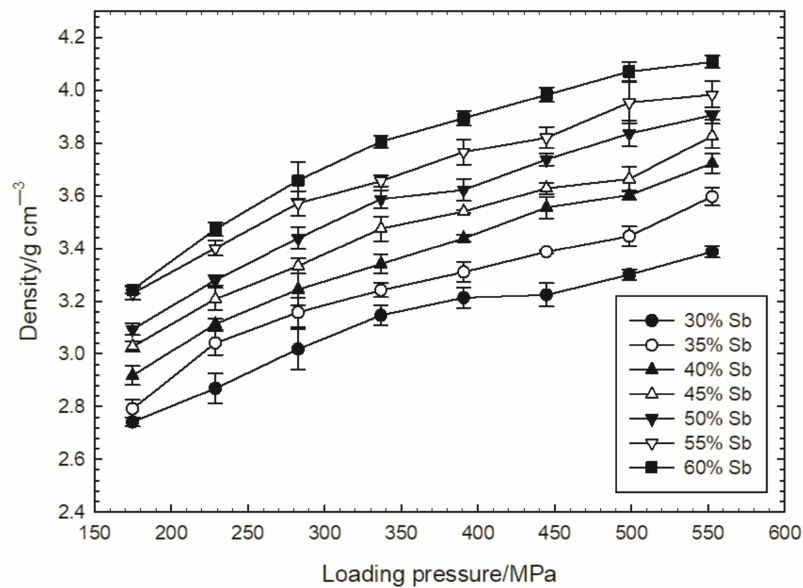
Figure 4. Dependence of the delay composition density on the loading pressure for different Sb